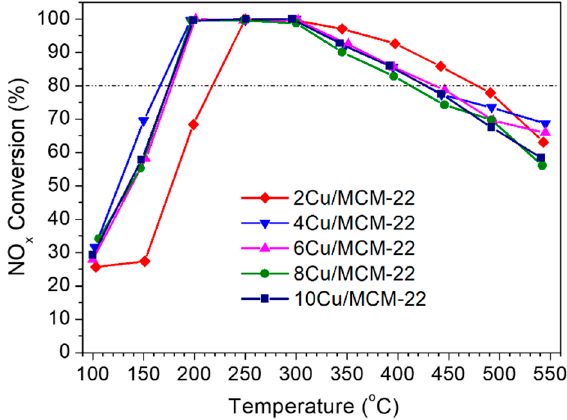
Figure 7. NO x conversion in NH 3 -SCR as a function of temperature over x Cu/MCM-22 zeolites. Compared with 2Cu/MCM-22, the NO x conversions of 4Cu/MCM-22 at a low temperature